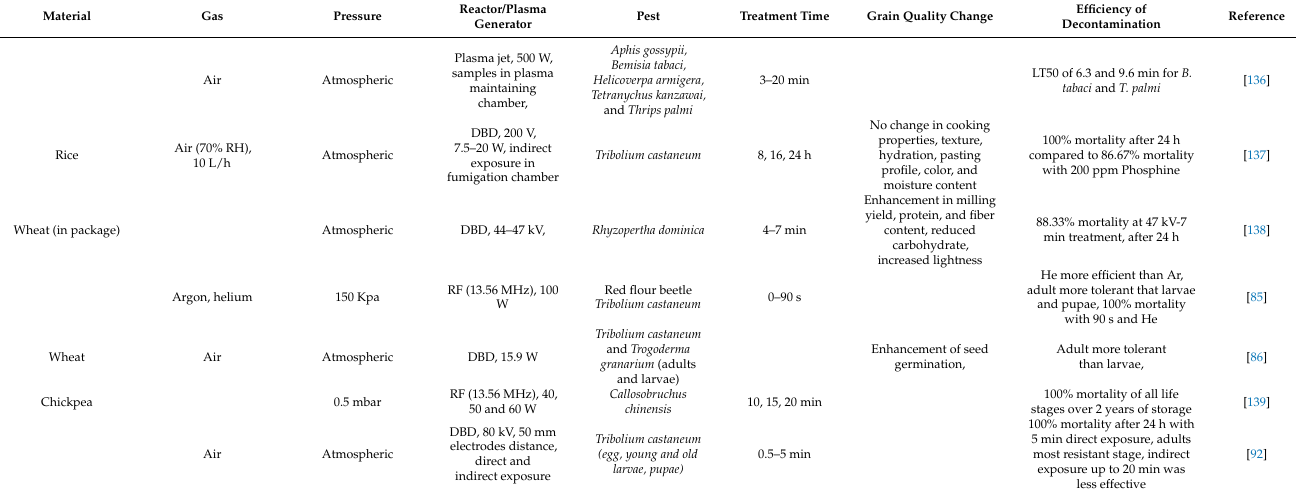
Table 4. Plasma treatment of grains for insect pest